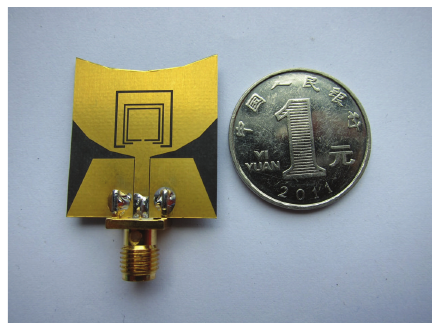
Figure 3: Photograph of the proposed antenna.